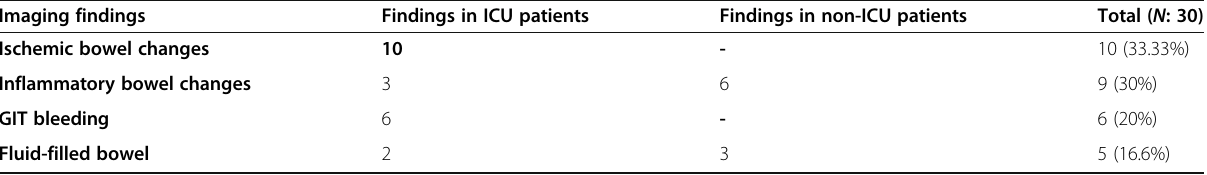
Table 2 Distribution of the imaging findings in the studied patients Imaging findings Findings in ICU patients Findings in non-ICU